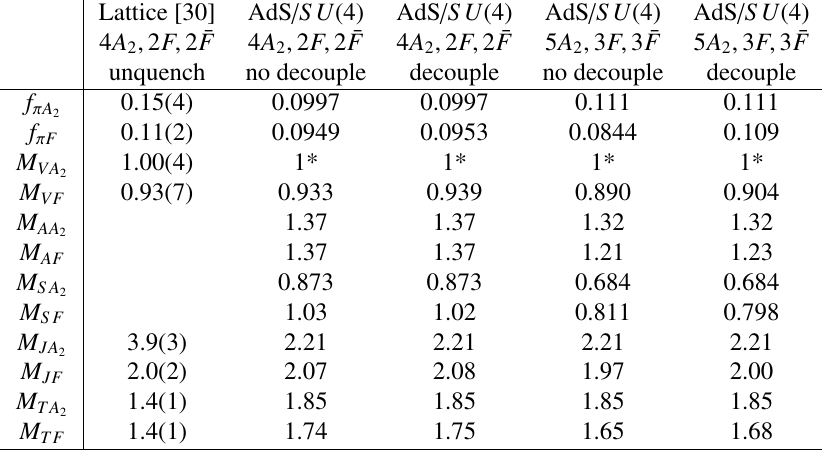
Table 2. SU(4) theories - the spectrum in a variety of scenarios and lattice data for